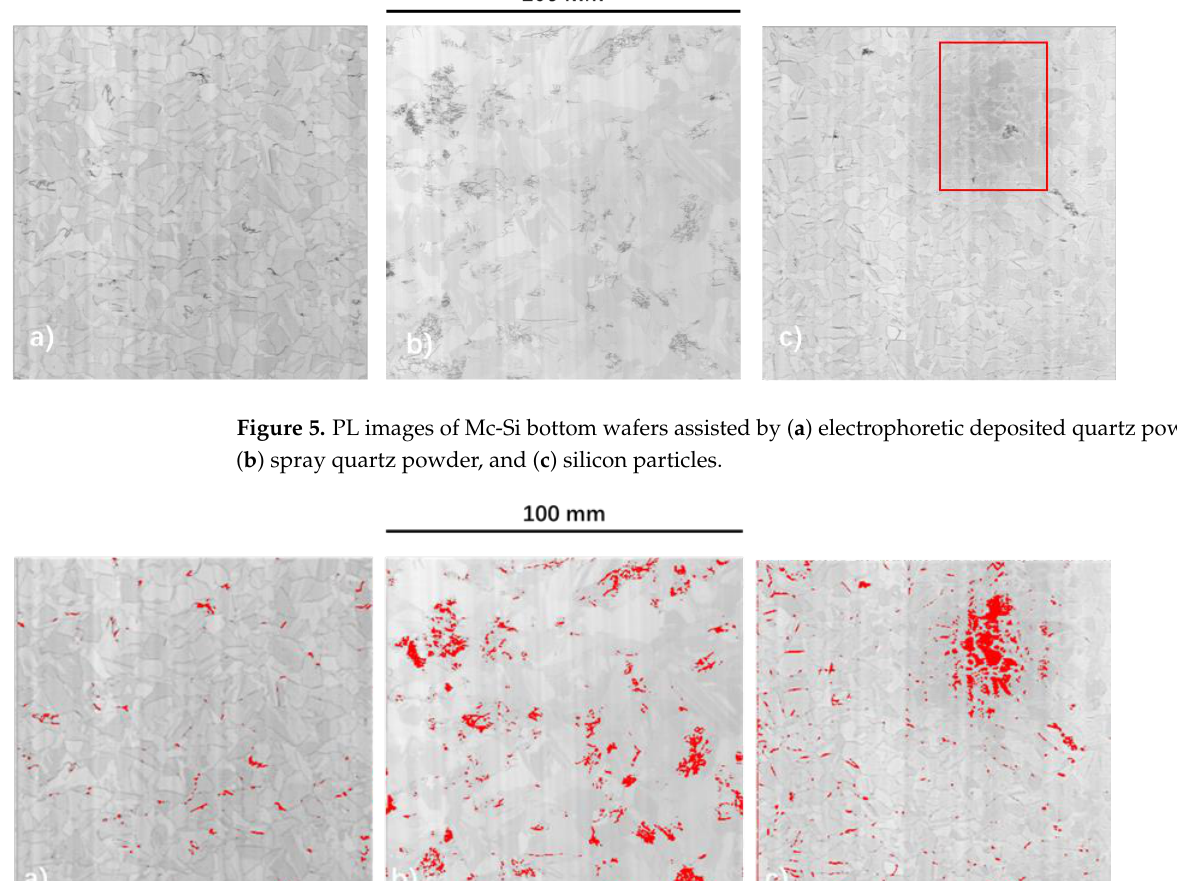
Figure 7. Dislocation distribution of Mc-Si at different heights. ( a ) Electrophoretic deposited quartz powder, ( b ) spray quartz powder, and ( c ) silicon particles.